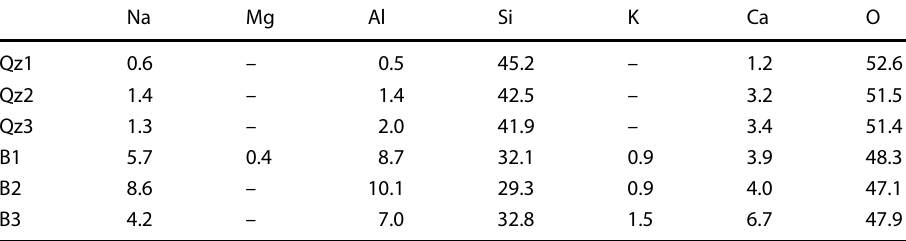
Locations of the spots are shown in Fig. 3. All values